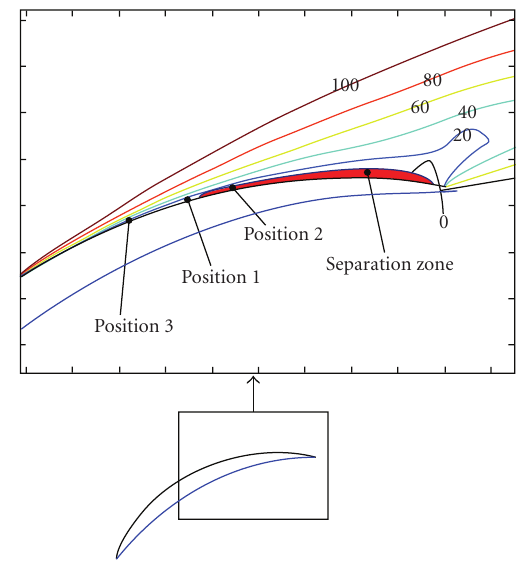
Figure 10: Axial velocity contour lines (m/s) and the positions at which plasma actuators are